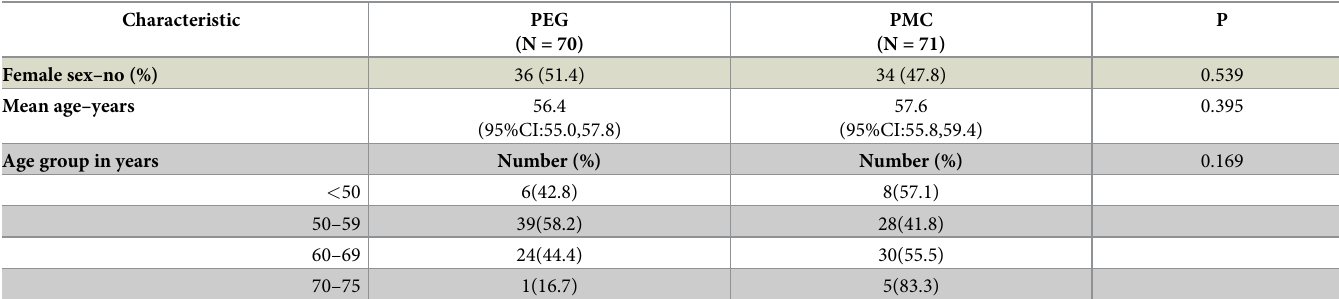
Table 2. Baseline patient